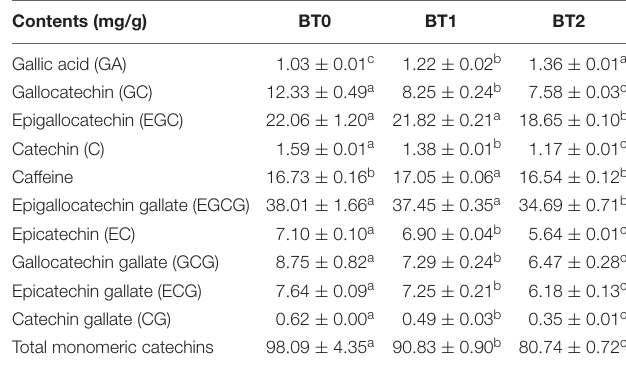
TABLE 1 | The chemical compositions of jade (BT0), medium-baked (BT1), and deep-baked (BT2) Tieguanyin oolong teas.